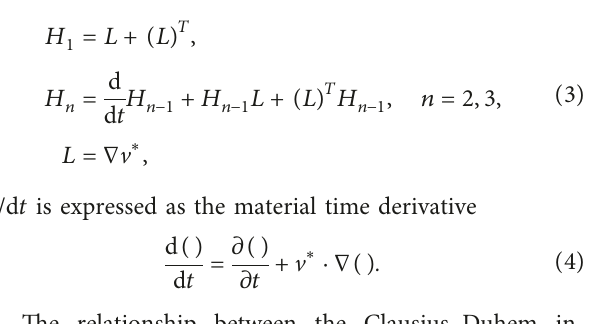
,h ,h , and h f θ ϕ